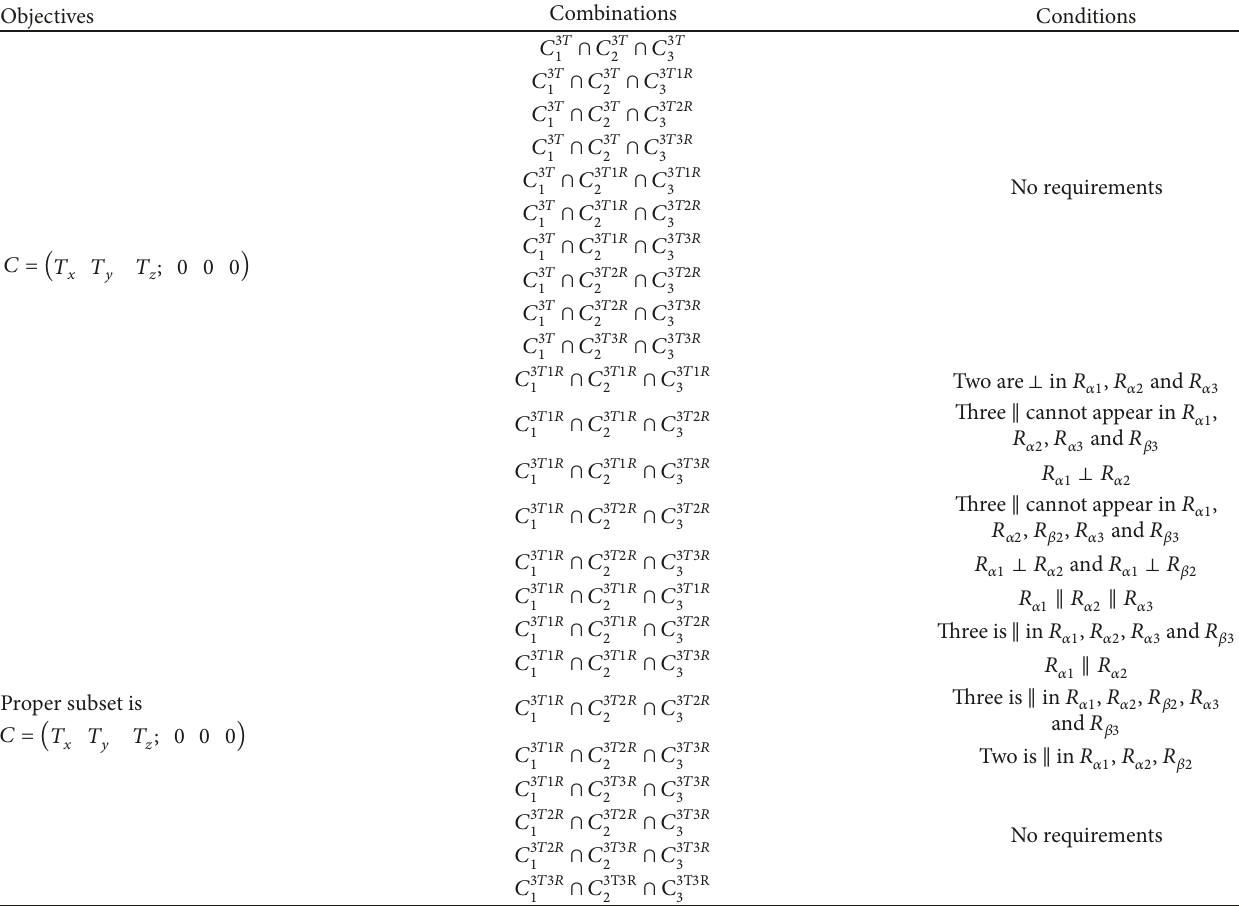
Table 2: Classification for the combinations of the branched robots.